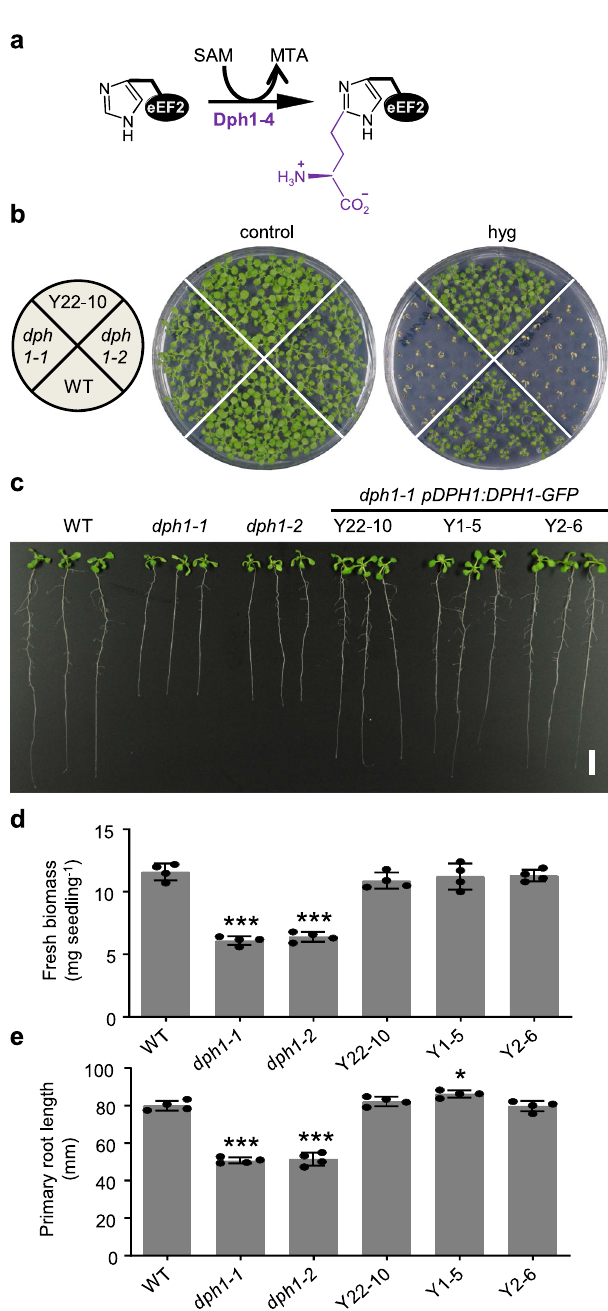
Fig. 1 Identi fi cation and phenotypes of Arabidopsis dph1 mutants. a Scheme of fi rst step of diphthamide biosynthesis in yeast and